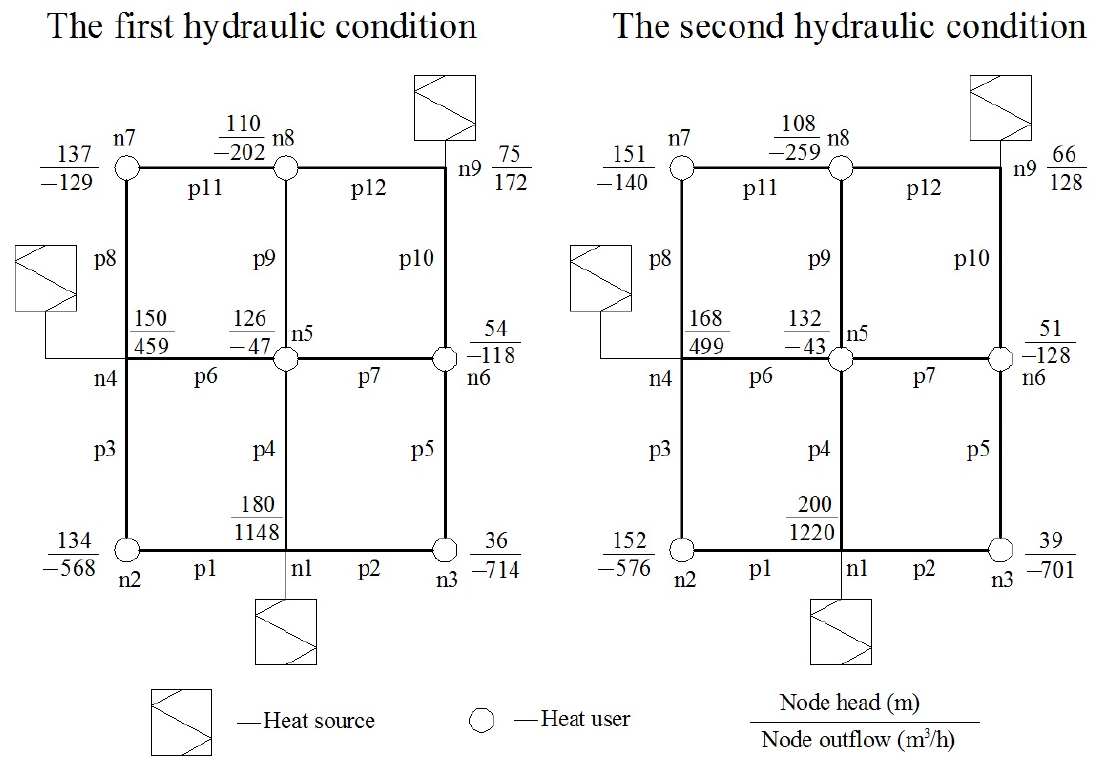
Figure 2. Schematic diagram of an example HN and known variables under two hydraulic condi- tions.